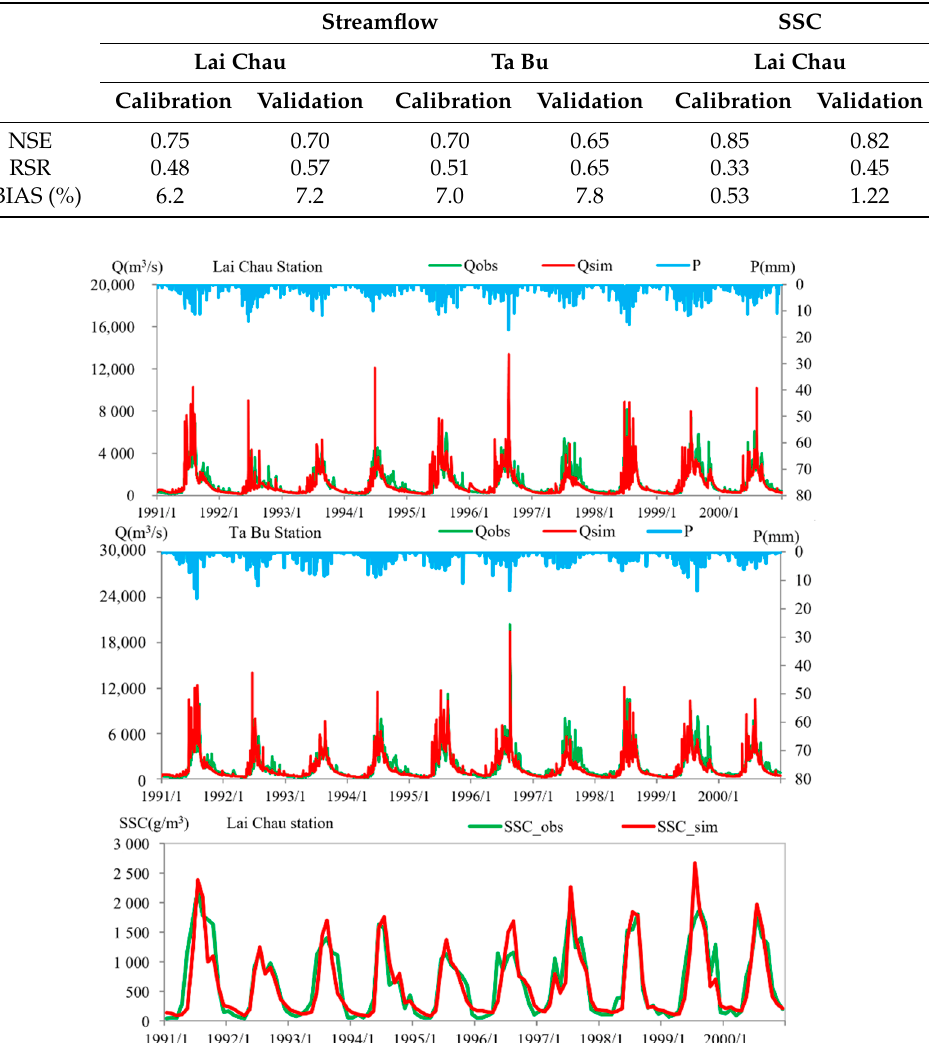
Figure 6. Comparison of observed and simulated daily streamflow (the Lai Chau and Ta Bu first and second figures, respectively) and monthly SSCs (bottom figure) in the DRB (calibration period: 1991–1995, validation period: 1996–2000).